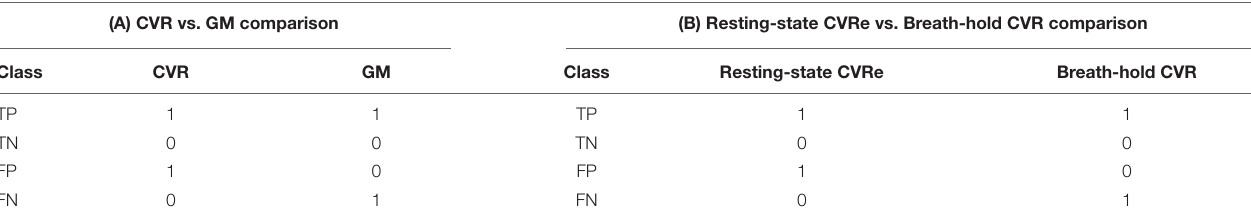
TABLE 1 | Voxel-wise classification in (A) : CVR vs. gray matter comparisons, and (B) resting-state CVRe vs. breath-hold CVR comparisons. (A) CVR vs. GM comparison (B) Resting-state CVRe vs. Breath-hold CVR comparison Class Resting-state CVRe Breath-hold